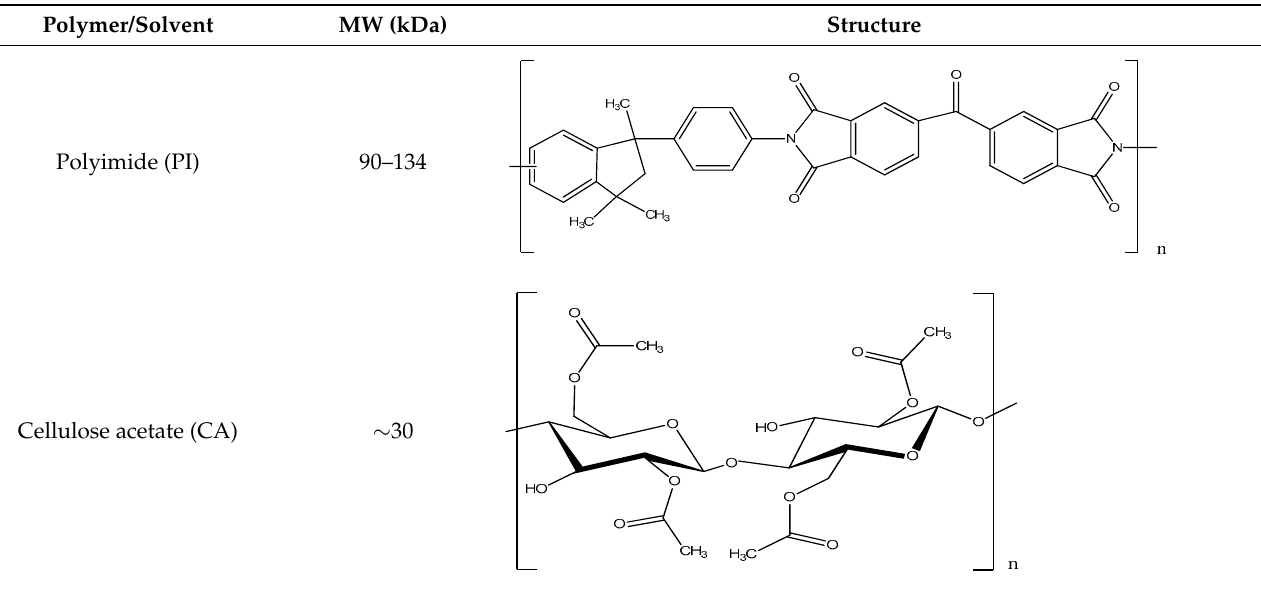
Table 1. Molecular weight (MW), structure of polymers, feed solutes and solvent used in this work. Polymer/Solvent MW (kDa) Structure